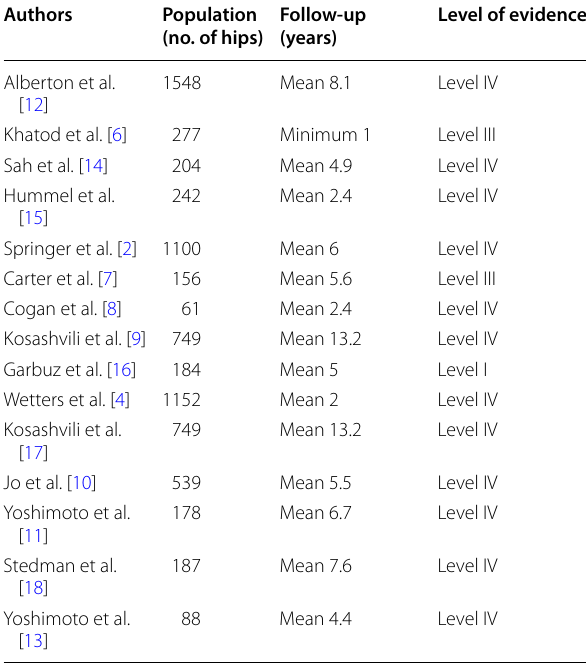
Table 3 Characteristics of the